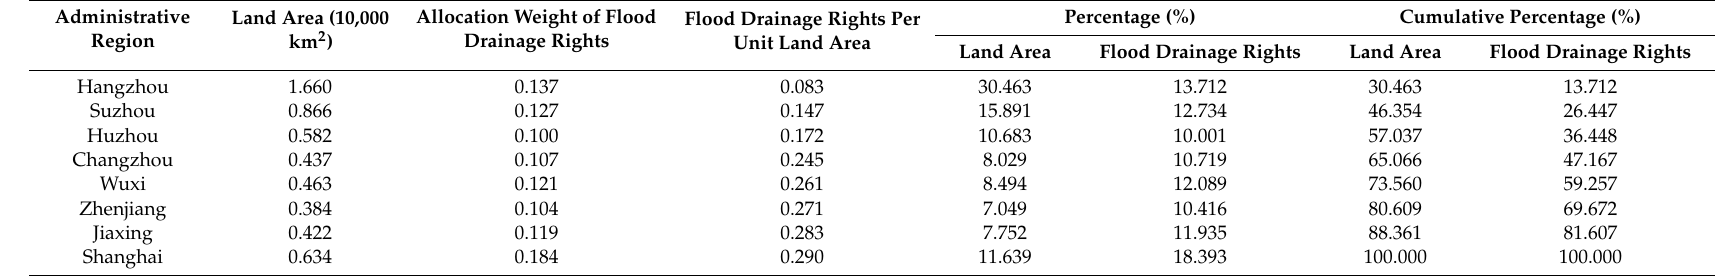
Table 8. Environmental Gini coe ffi cients based on land